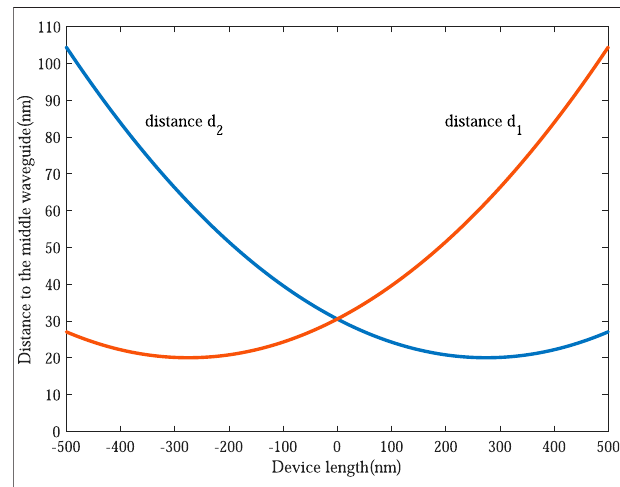
FIGURE4| Distancebetweenthe input/output and middlewaveguides.